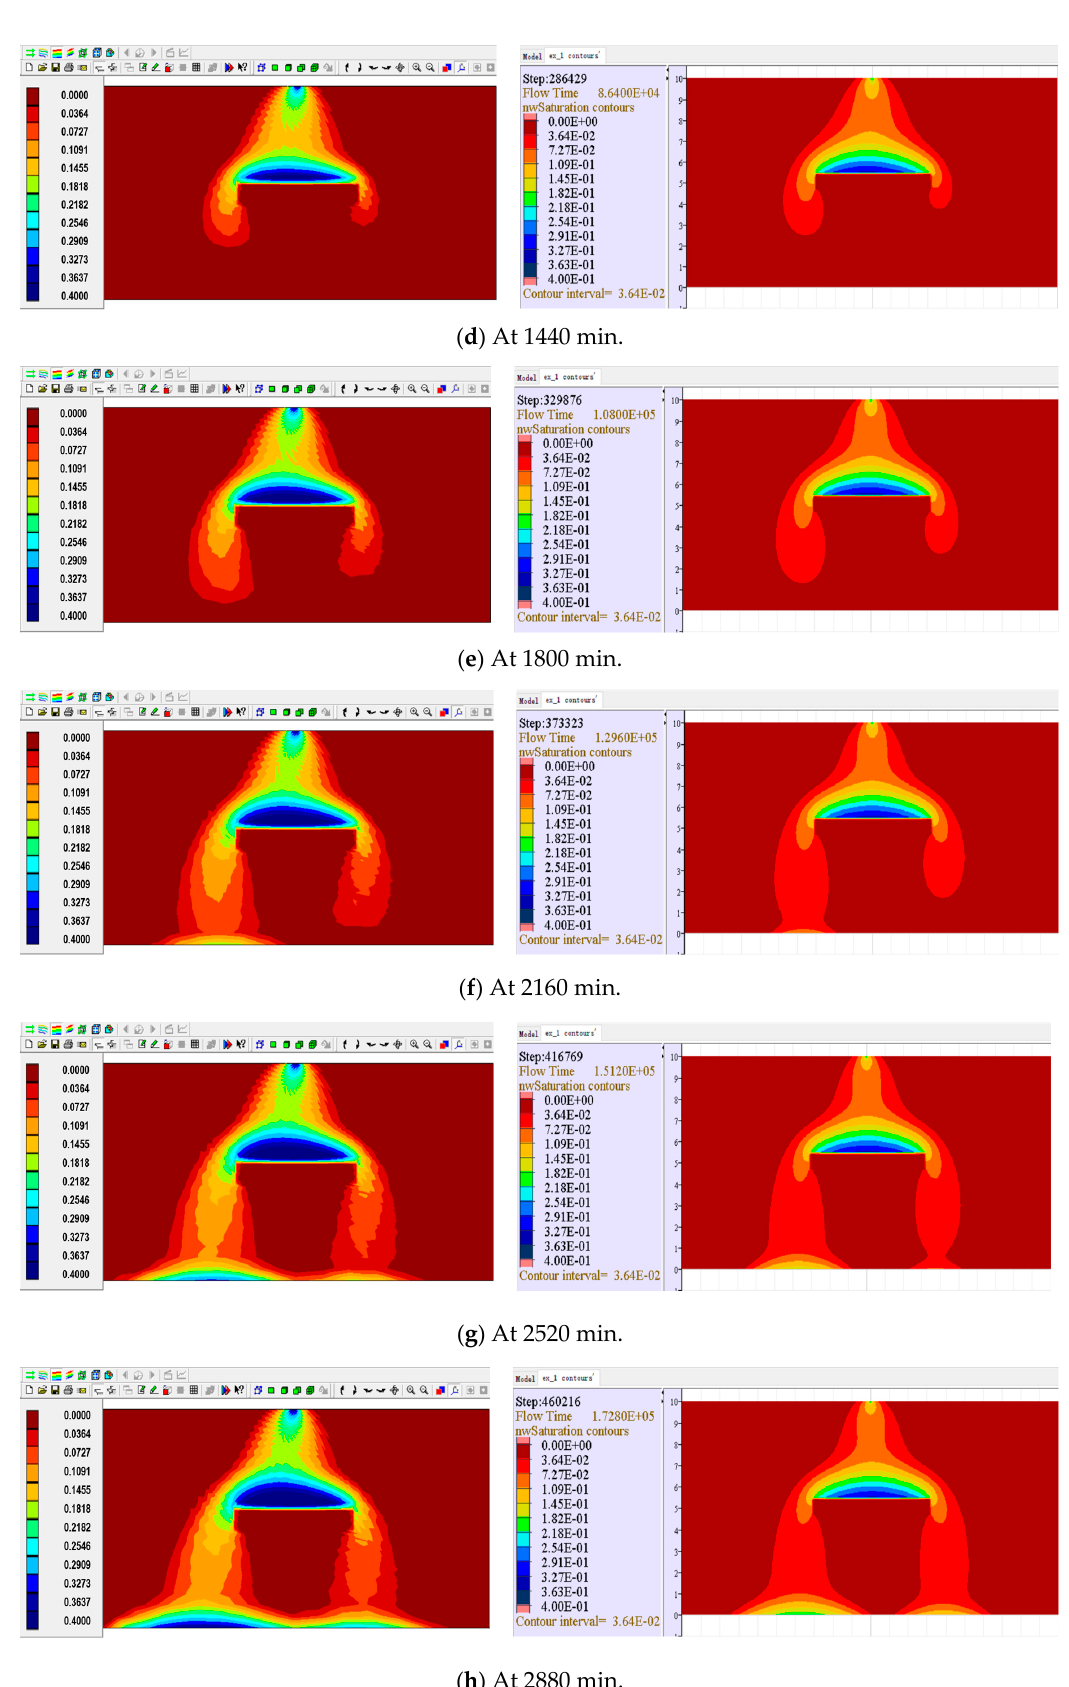
Figure 11. Distribution of saturation with regards to trichloroethylene and its change with time simulated using self-developed source code ( left ) and FLAC ( right